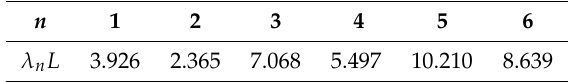
Table A1. The first six values of λ n L .